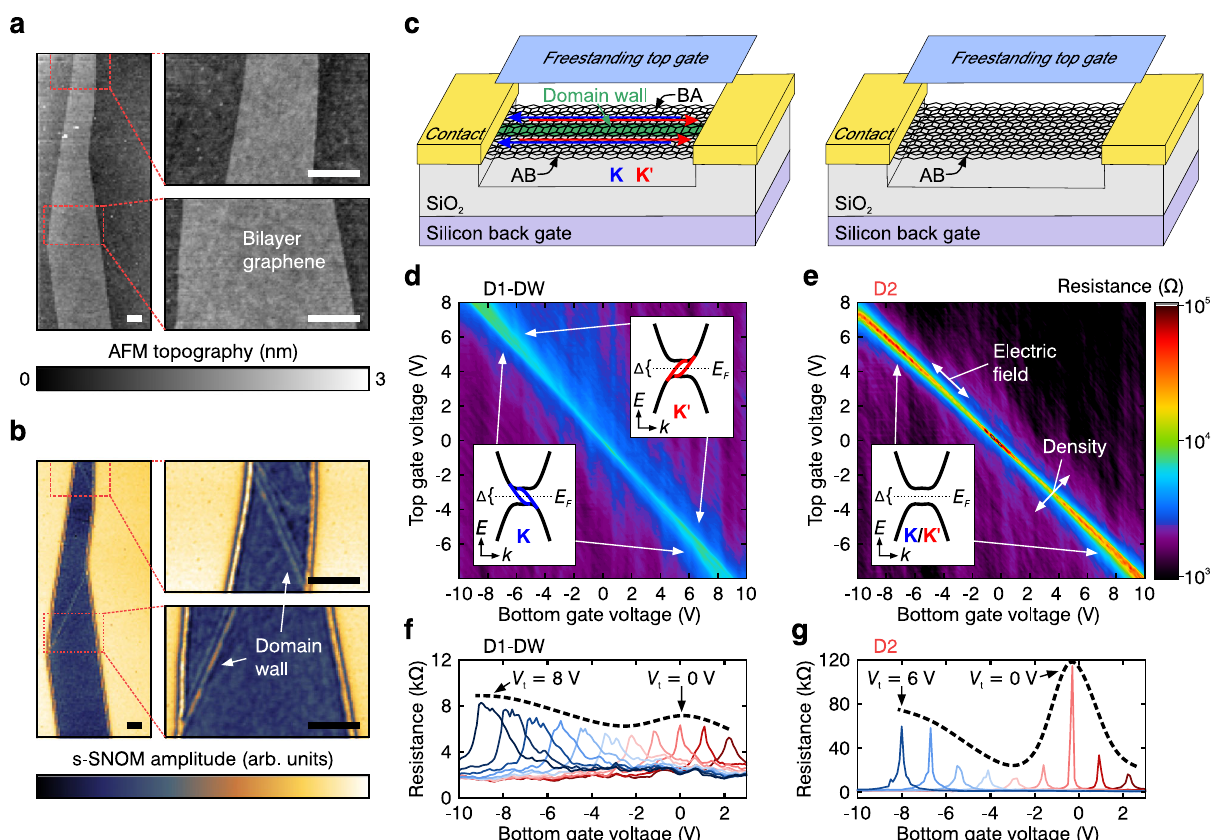
Fig. 1 Topologically-protected states in bilayer graphene. a , b Atomic force microscopy image ( a ) and scattering-type scanning near- fi eld microscopy image ( b ) of a bilayer graphene fl ake, with high-resolution zoom-in scans on the right. The scale bars are 0.5 μ m. c Freestanding dually gated bilayer graphene devices schematically shown with (left) and without domain wall (right) connecting the contacts. Topological valley transport along the domain wall is shown in blue and red in the K- and K 0 -valley, respectively. d , e Resistance map as a function of top and bottom gate voltage for device D1-DW ( d with domain wall) and D2 ( e without domain wall). Insets: Electronic band structure of bilayer graphene with ( d ) and without a domain wall ( e ) for an applied electric fi eld. Δ is the electric fi eld induced bandgap, E F the Fermi level and the blue (red) lines indicate topologically protected, doubly spin degenerate chiral states in the K(K 0 )-valley. f , g Trace of the resistance as a function of V b for various V t with steps of 1 V shown for device D1-DW ( f ) and D2 ( g ). The dashed lines indicate the envelope of the resistance and are a guide to the